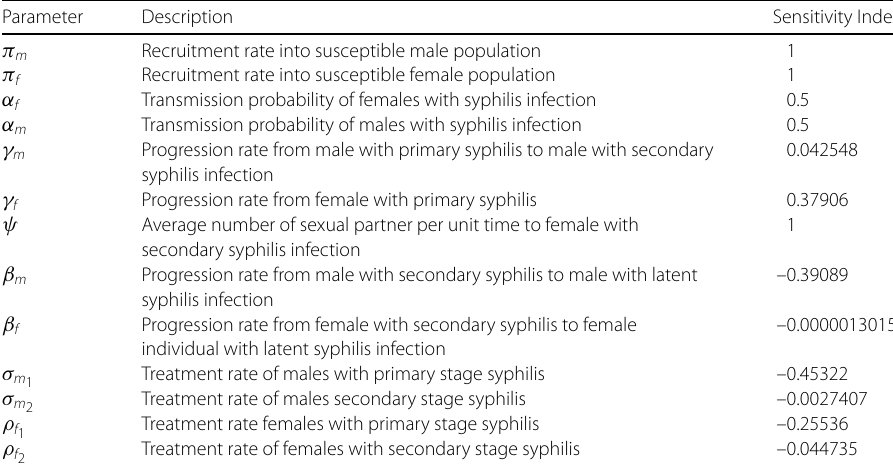
Table 3 Sensitivity indices of syphilis model R